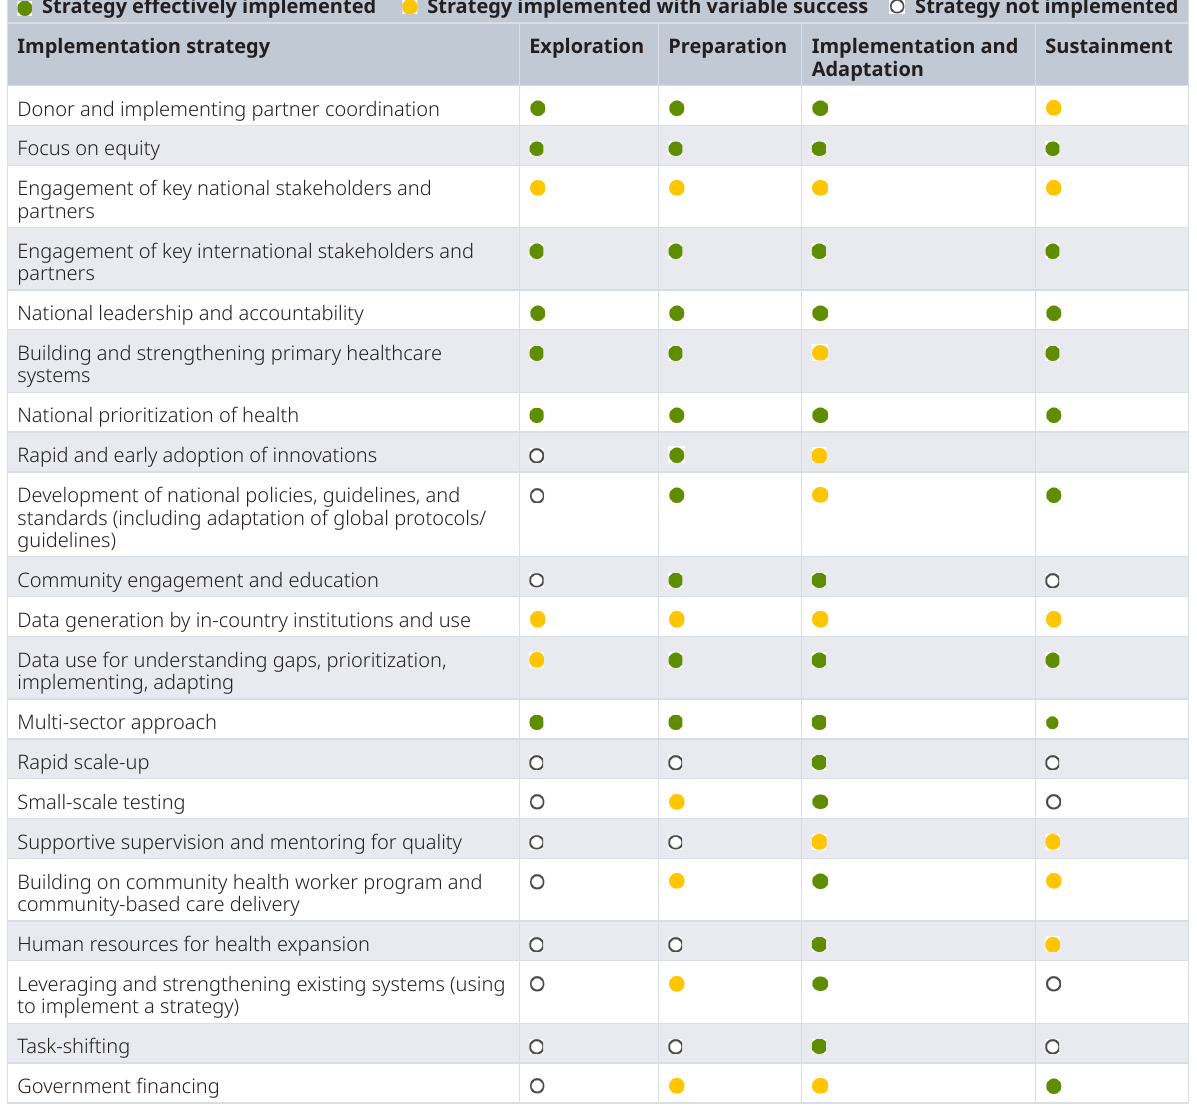
Table 3. Common Implementation Strategies by Exploration, Preparation, Implementation, Adaptation, and Sustainment Stages in